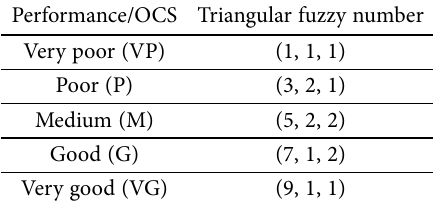
Table 3. Linguistic variables-symmetric case Performance/OCS Triangular fuzzy number